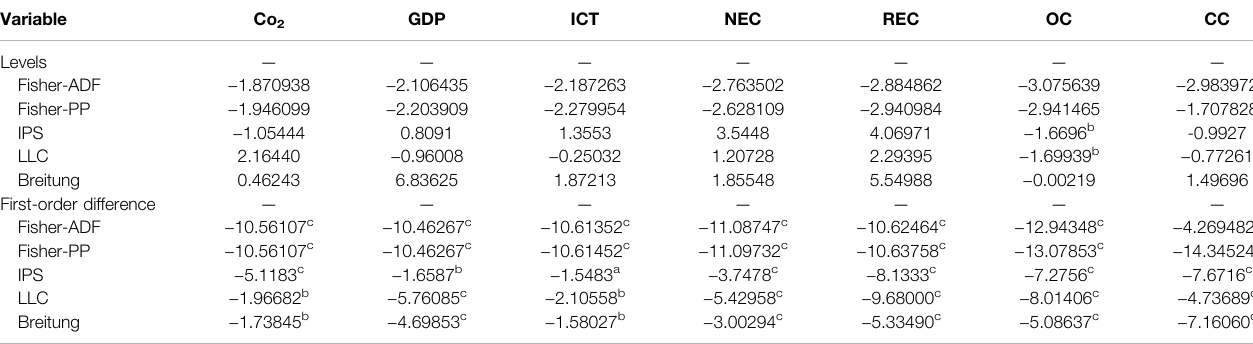
TABLE 4 | stationary test results of each